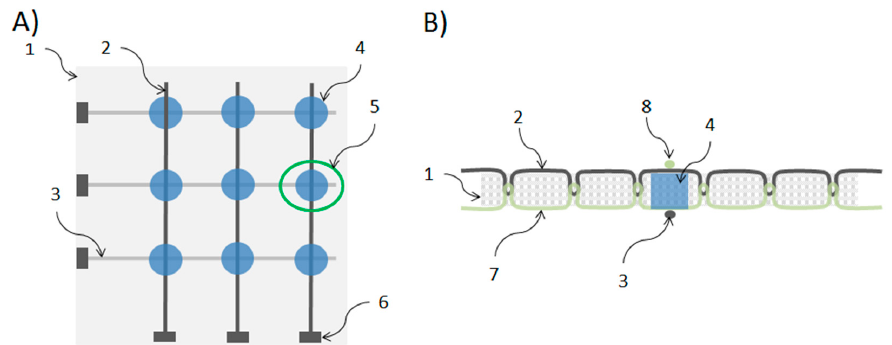
Figure 1. Scheme of a textile pressure sensor. ( A ) Top view of a 3 × 3 array where it is possible to identify: (1) base fabric, (2) top conductive path, (3) bottom conductive path, (4) conductive polymer treated zone, (5) single sensing element or sensel, and (6) connector or electrical contact for measuring; ( B ) Transversal view of a sensel (5 of panel A) illustrating the relation between the base fabric (1), the conductive threads (2 and 3), the non-conductive threads (7 and 8) and polymer-treated zone (4) that create the force-sensitive structure (the connector (6) is not shown in this view).